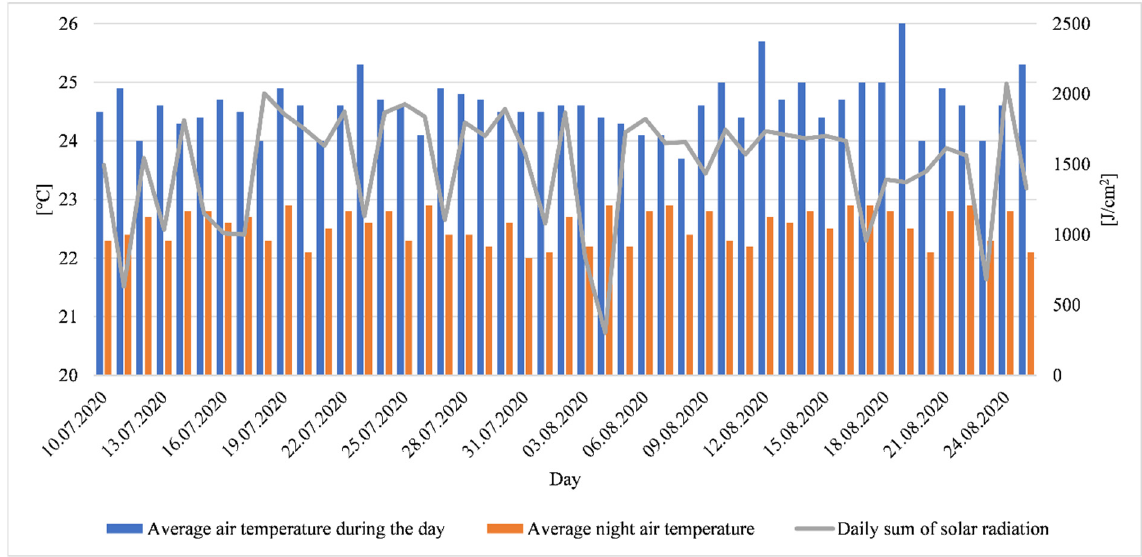
Figure 1. Climate parameters in the cultivation chamber during the experiment—season 2020.